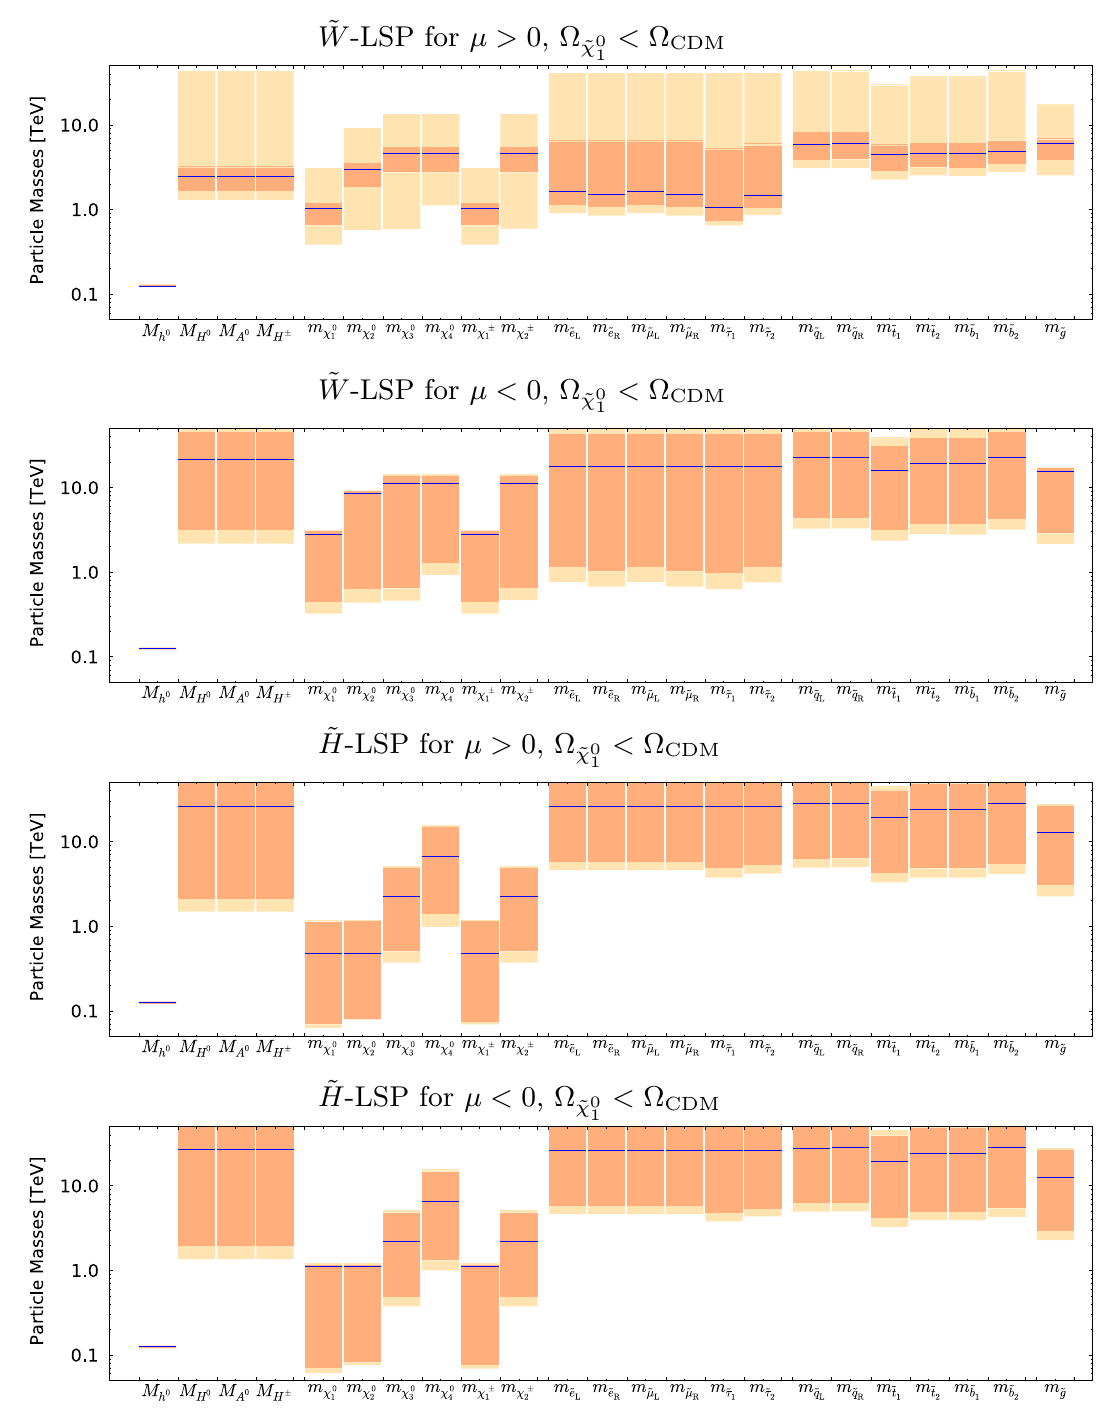
Fig. 16 The ranges of masses obtained for the wino-like LSP case with μ > 0 ( top panel ) and μ < 0 ( second panel ), and also for the Higgsino-like LSP case for μ > 0 ( third panel ) and μ < 0 ( bottom panel ), relaxing the assumption that the LSP contributes all the cold TeV, which is the right ball-park in our scenario. We see that with 3000 fb − 1 the LHC could nip the tip of the 95% CL region in these planes, whereas with the same luminosity